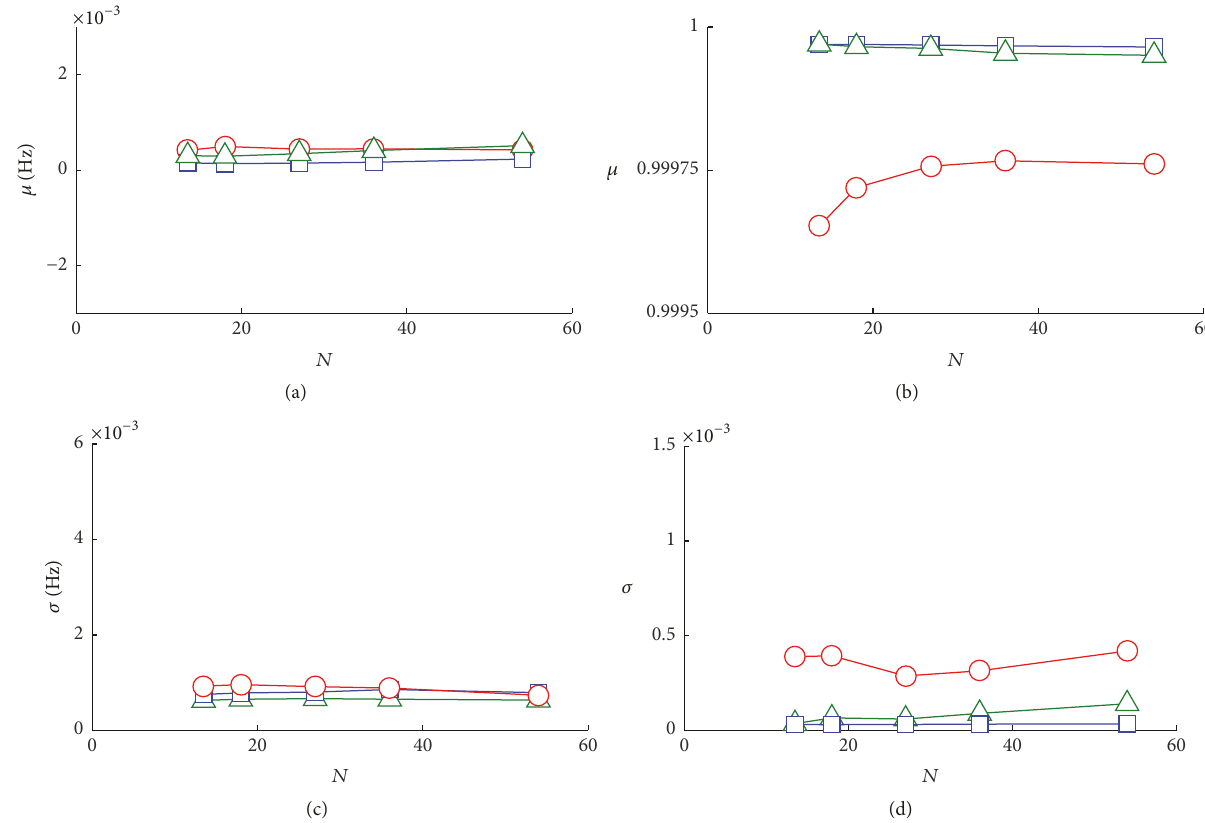
Figure4:ResultsoftheMCMCsimulationsforpLSCFasfunctionof N ( R =5mHz):meanvalueoftheerrorfortheeigenfrequencyestimation